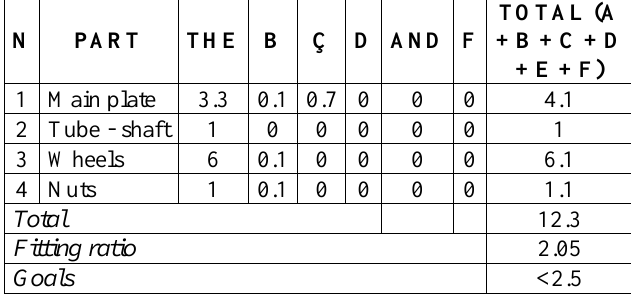
Table 6: Result of the analysis of the conceptual landing gear assembly.